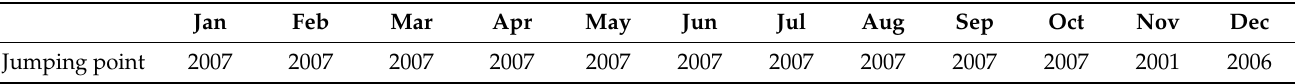
Table 2. The results of the detected changing points in the lake’s surface area.